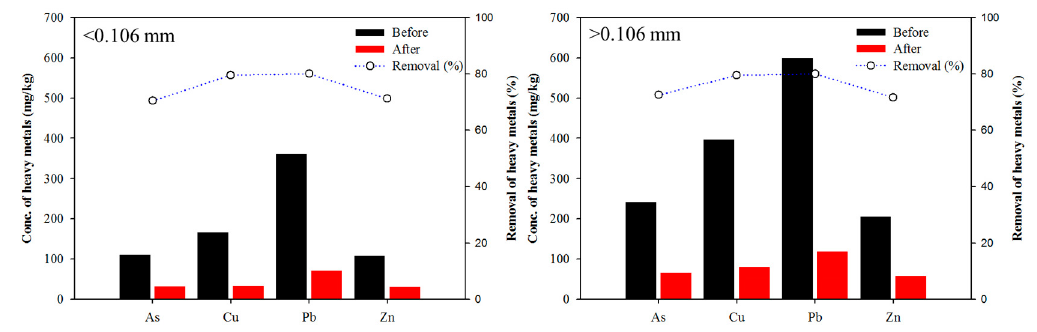
Figure 9. E ff ect of size fraction ( ± 0.106 mm) on the extraction of As, Cu, Pb, and Zn from the batch test Figure 9. Effect of size fraction (±0.106 mm) on the extraction of As, Cu, Pb, and Zn from the batch with mixture solution (0.6 M sulfuric acid and 0.6 M phosphoric acid, test with mixture solution (0.6 M sulfuric acid and 0.6 M phosphoric acid, 1:1).